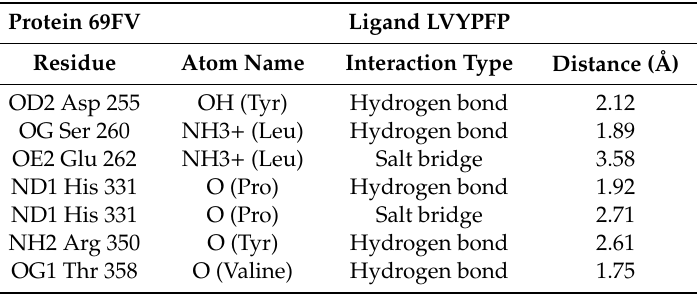
Table 4. LVYPFP docking results.